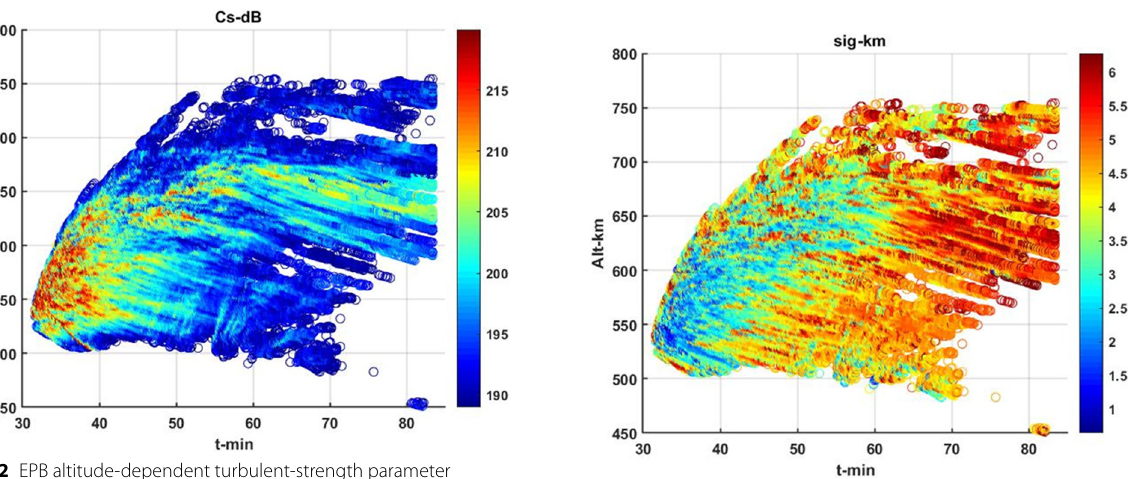
Fig. 4 Altitude-dependent EPB break-scale